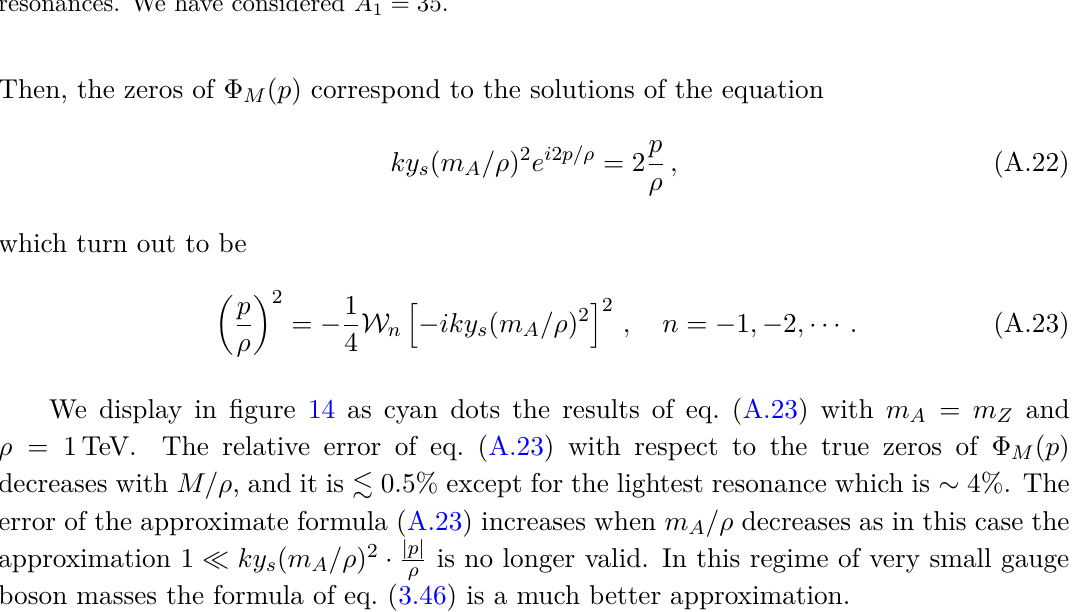
Figure 15 . M/ρ (left panel) and Γ /M (right panel) as a function of the gauge boson mass m A /ρ . It is displayed the results for the first (solid blue), second (dashed red) and third (dotdashed brown) resonances. We have considered A 1 = 35